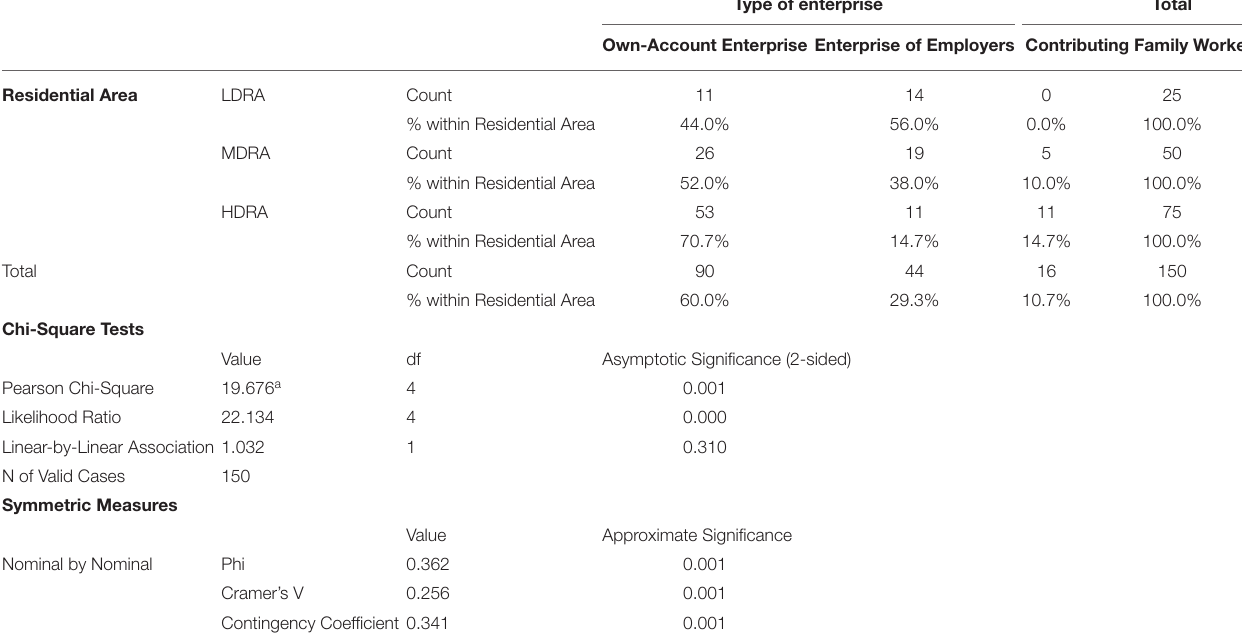
TABLE 2 | Association between residential area and type of